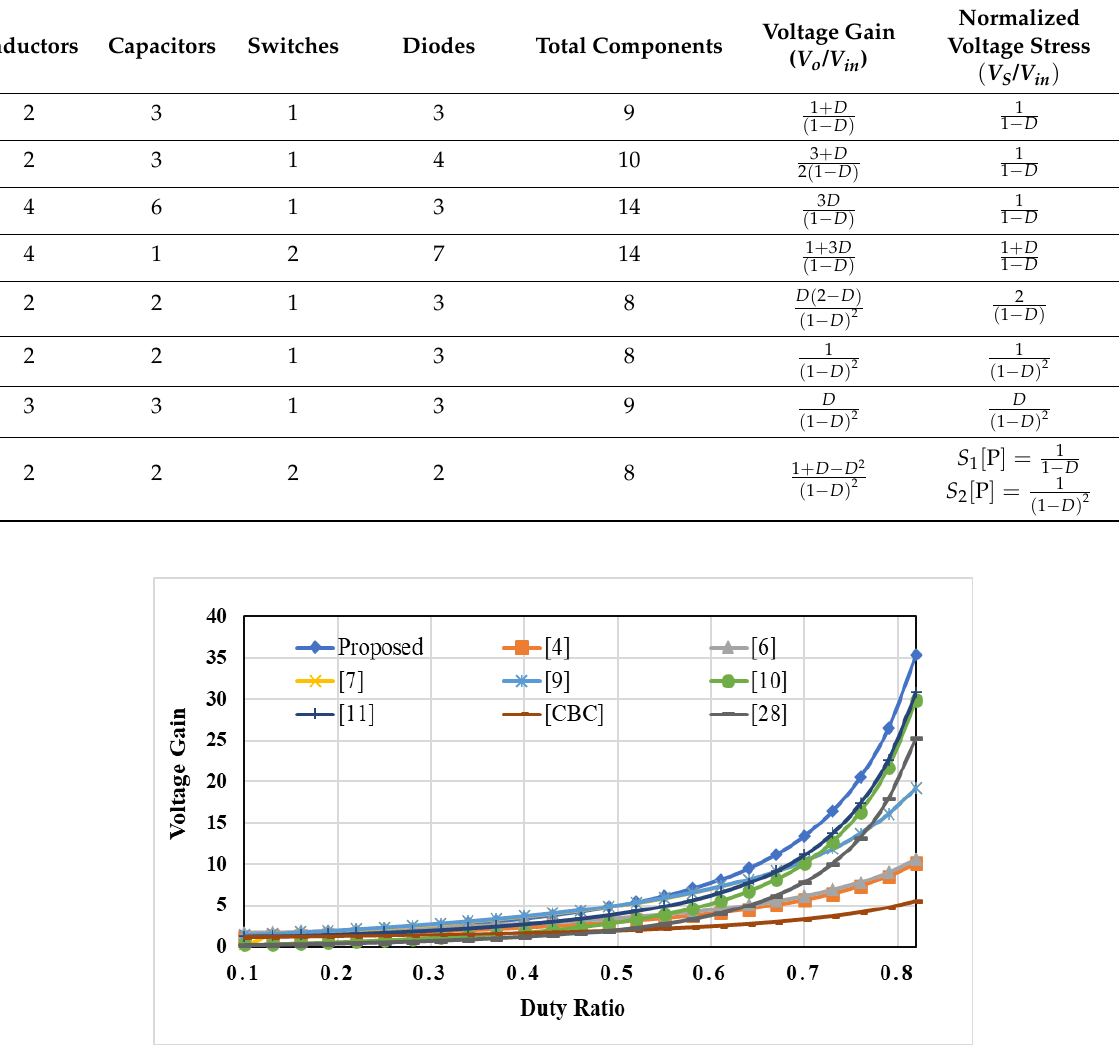
Figure 5. Comparision of the Voltage gain for different converters.